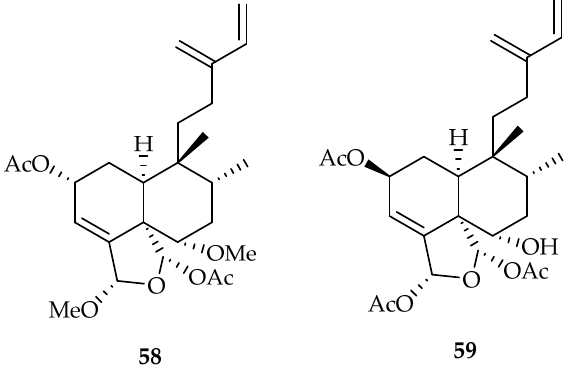
Figure 25. Structures of compounds 58 [39] and 59 [40]. Guo et al., one year later, isolated further six new clerodane diterpenes, which were also named kurzipenes A–F, although they have a different structure [40]. Their cytotoxic activity was evaluated against four cell lines (A549, K562, HeLa, and HepG2) using the MTT assay and etoposide as a positive control. Only compound 59 showed promising activities with IC 50 values < 20 µ M against all cancer cell lines used (Figure 25). The same authors also isolated five other new clerodane diterpenoids from the twigs of Casearia kurzii , named kurziterpenes A-E, which exhibited cytotoxic activities against the A549, HeLa, and HepG2 cell lines [41]. Only kurziterpene B 60 , kurziterpene D 61 , and kurziterpene E 62 showed IC 50 values lower than 20 µ M, using etoposide as a positive control. All three compounds have an IC 50 value lower than the positive control against the HeLa cells (Figure